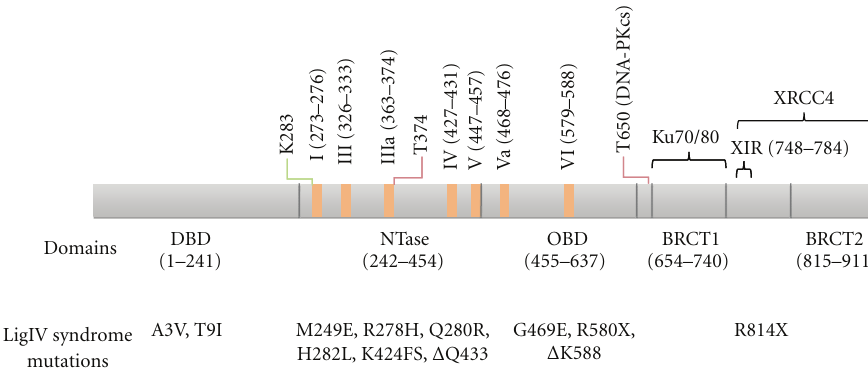
Figure 9: Schematic diagram of human DNA ligase IV. Domain boundaries shown in the figure are based on the crystallographic structure of human DNA ligase I [73] and BRCT domains of LigIV [94]. Conserved motifs (I, III, IIIa, IV, V, Va, and VI) are shown in orange rectangles [69, 70]. The conserved catalytic lysine is indicated in green line. Reported phosphorylation sites are indicated by red lines [81, 99]. LigIV syndrome mutations are shown under domains [72, 100]. Ku and XRCC4 interaction regions are indicated with black brackets [29, 84,